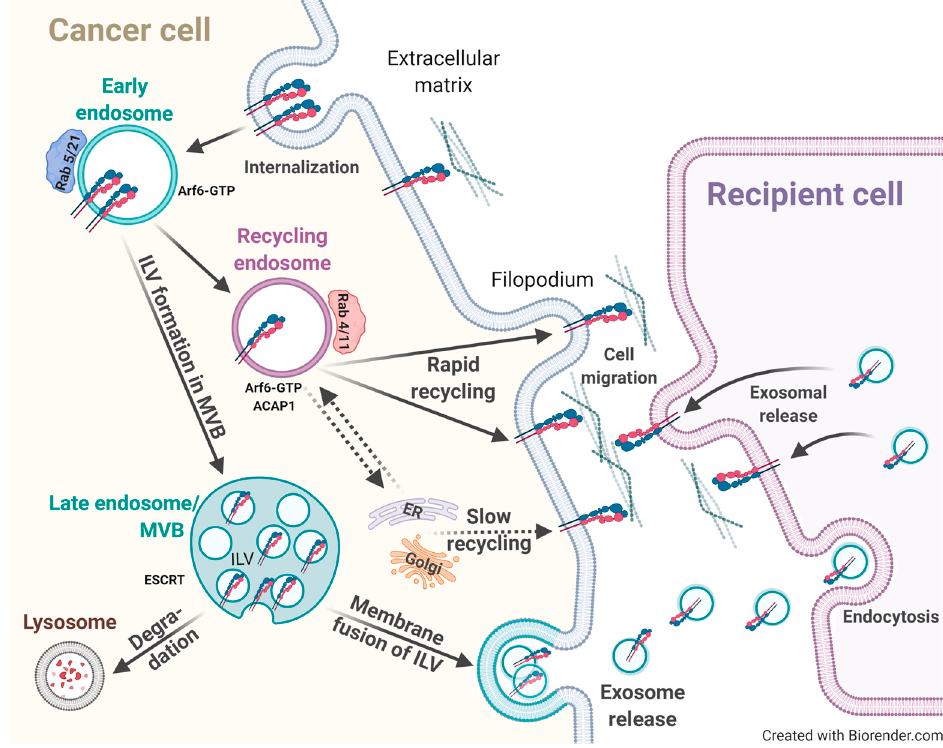
Figure 4. Integrin internalization, sorting, and recycling. Integrin internalization occurs either clathrin-mediated or caveolar involving the dynamin GTPase to form vesicles. Rab GTPase family members and Arf GTPases are intimately involved in integrin trafficking, implicating ACAP1 in rapid integrin recycling from Arf6-positive endosomes. Integrin endocytosis to early endosomes is triggered by Rab5 and Rab21. Integrin recycling proceeds either through a short/rapid-loop by fusion to early endosomes implicating Rab4 signaling, or a long/slow-loop pathway, involving Rab11 signaling, delivering integrins back to the plasma membrane and into filopodia. This facilitates cell adhesion and enhances cell migration. Early endosomes mature to late endosomes/multivesicular bodies (MVBs) via the invagination of the endosomal membrane resulting in intraluminal vesicles (ILVs), which may be prone to degradation in lysosomes. Other receptors are recognized by specific coat proteins and sorted either to the plasma membrane, the trans-Golgi network, or in some cases to the endoplasmic reticulum (ER), thus evading degradation. Constitutive exocytosis of ILVs carrying integrins occurs upon their fusion with the cell membrane. Formed exosomes carrying integrins are taken up by recipient cells where they enrich the cell surface integrin density and thereby increase cell migration. Thus, the proportion between integrins depends on the balance between either their recycling or degradation exerting tremendous consequences for integrin signaling and the biological events arising thereof.